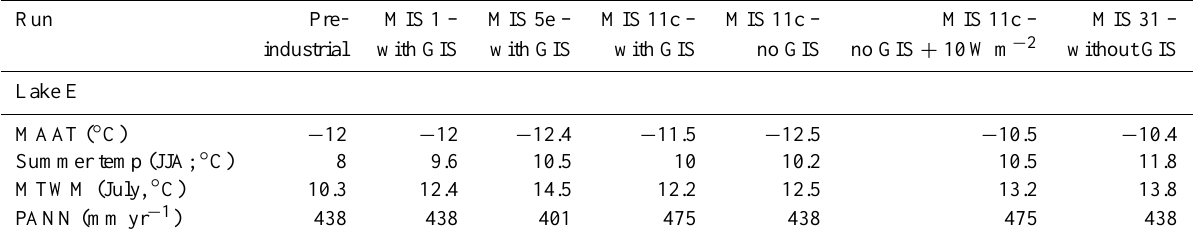
Table 2. List of GCM simulations with corresponding variables at the grid cell location of Lake E. Mean annual air temperature (MAAT), summer temperature (JJA), mean temperature of the warmest month (MTWM; July) and mean annual precipitation (PANN) are given below. Run Pre- industrial with GIS with GIS with